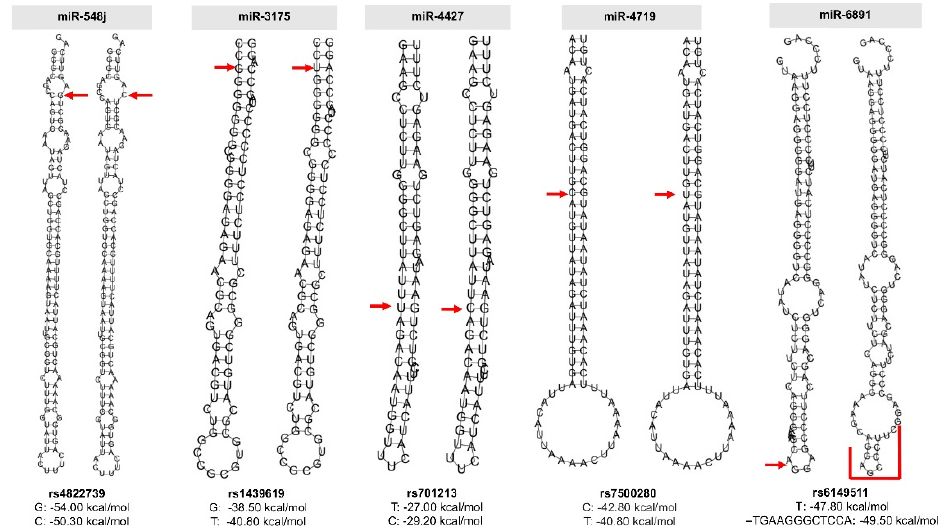
Figure 2. Secondary structure modeling of genetic variants in the pre-miRNAs. The predicted structures of pre-miRNAs with common allele (left) and the variant (right) are shown. A red arrow indicates the position of the allele. The free energies of both alleles are also shown.